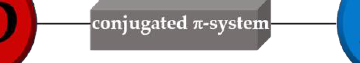
Figure 2. ”Push-pull” system.